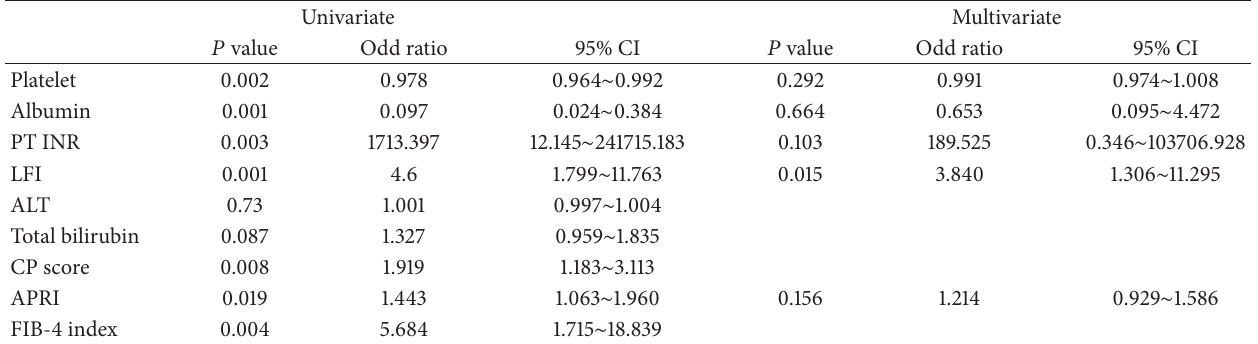
Table 3: Univariate and multivariate logistic regression of predicting F4 stage.